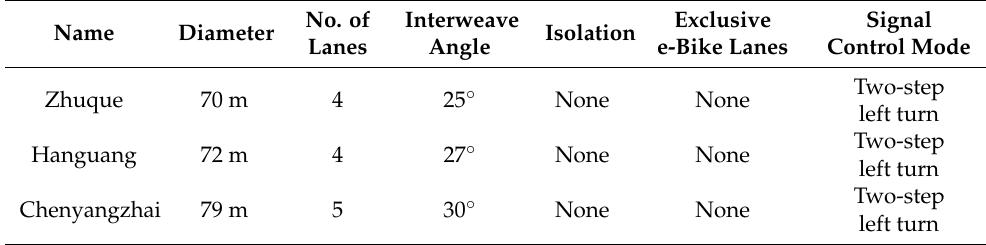
Table 1. Summary of detailed information about roundabouts.